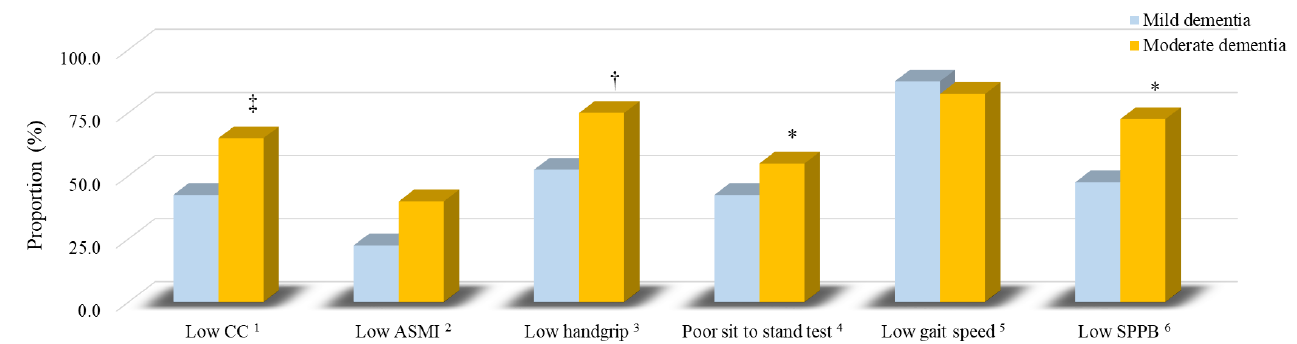
Figure 1. The proportion of sarcopenia components of patients with dementia. Blue is mild de- mentia; yellow is moderate dementia. 1 CC for male: <34 cm; female: <33 cm. 2 ASMI for male: <7.0 kg/m 2 ; female: <5.4 kg/m 2 . 3 Handgrip strength for male: <28 kg; female: <18 kg. 4 Five-time sit to stand test ≥ 12 s. 5 The gait speed <1.0 m/s. 6 The SPPB score ≤ 9. *, p < 0.05; †, p = 0.06; ‡, p = 0.07. ASMI, appendicular skeletal muscle mass index; CC, calf circumference; SPPB,